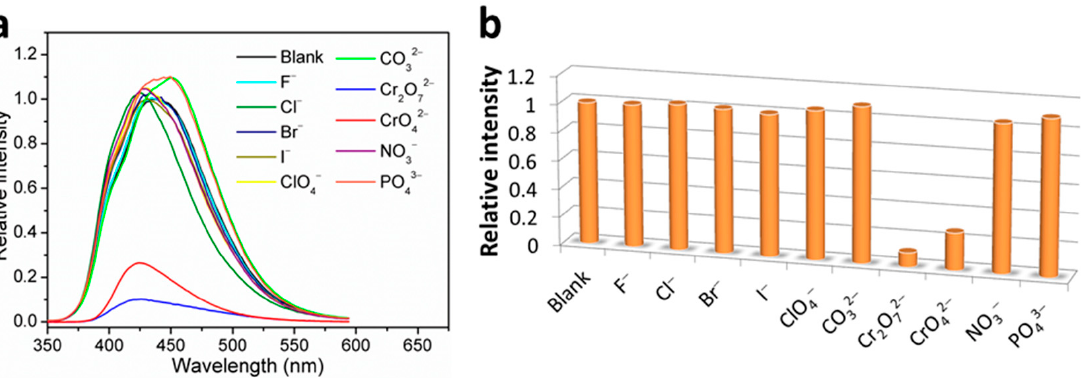
Figure 7. ( a ) Fluorescence emission spectra and ( b ) fluorescence relative ratio responses of 1 in H 2 O suspensions containing various anions at 1.0 mM.